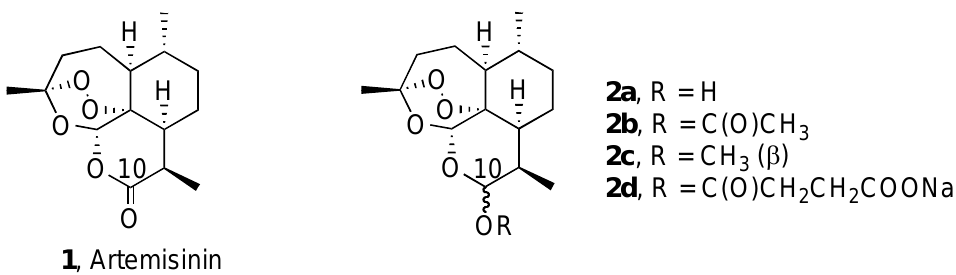
Figure 1. First Generation Semi-Synthetic Derivatives of